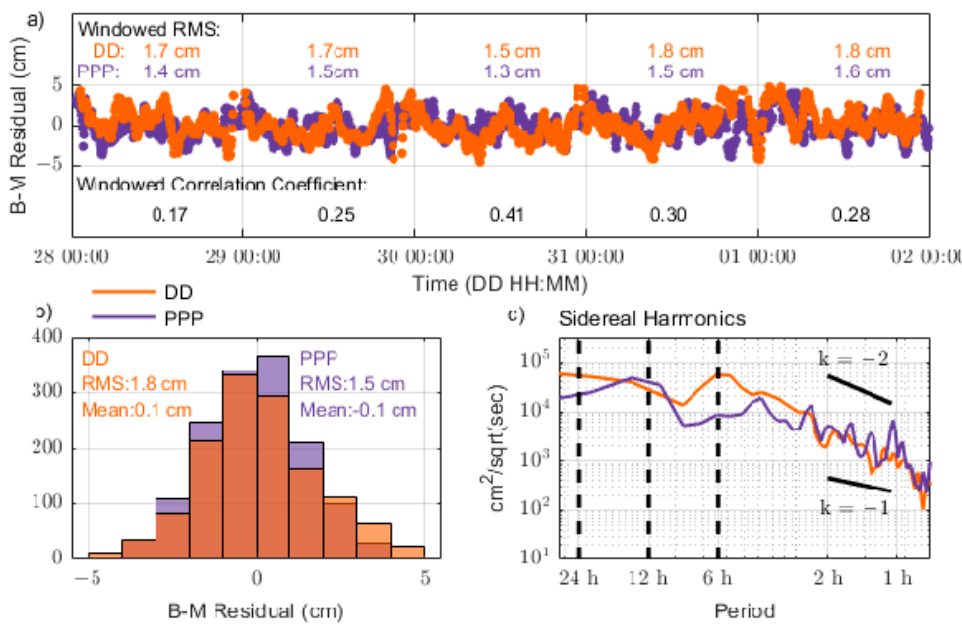
Figure 5. Statistics of B-M residuals from DD and PPP GPS-only solutions. Panel ( a ) includes the DD timeseries residual (orange) and PPP timeseries residual (purple) against the in situ mooring. Some noticeable in-phase common mode signals can be observed. Daily windowed RMS for both solutions and correlation coefficients between the two are shown in the upper panel. Panel ( b ) has histograms for both with same colour indication. Panel ( c ) presents the spectra, with sidereal harmonics shown in black dashed lines to help identify the frequency band of the signals. Reference lines for flicker (k = − 1) and random walk (k = − 2) noise are shown.